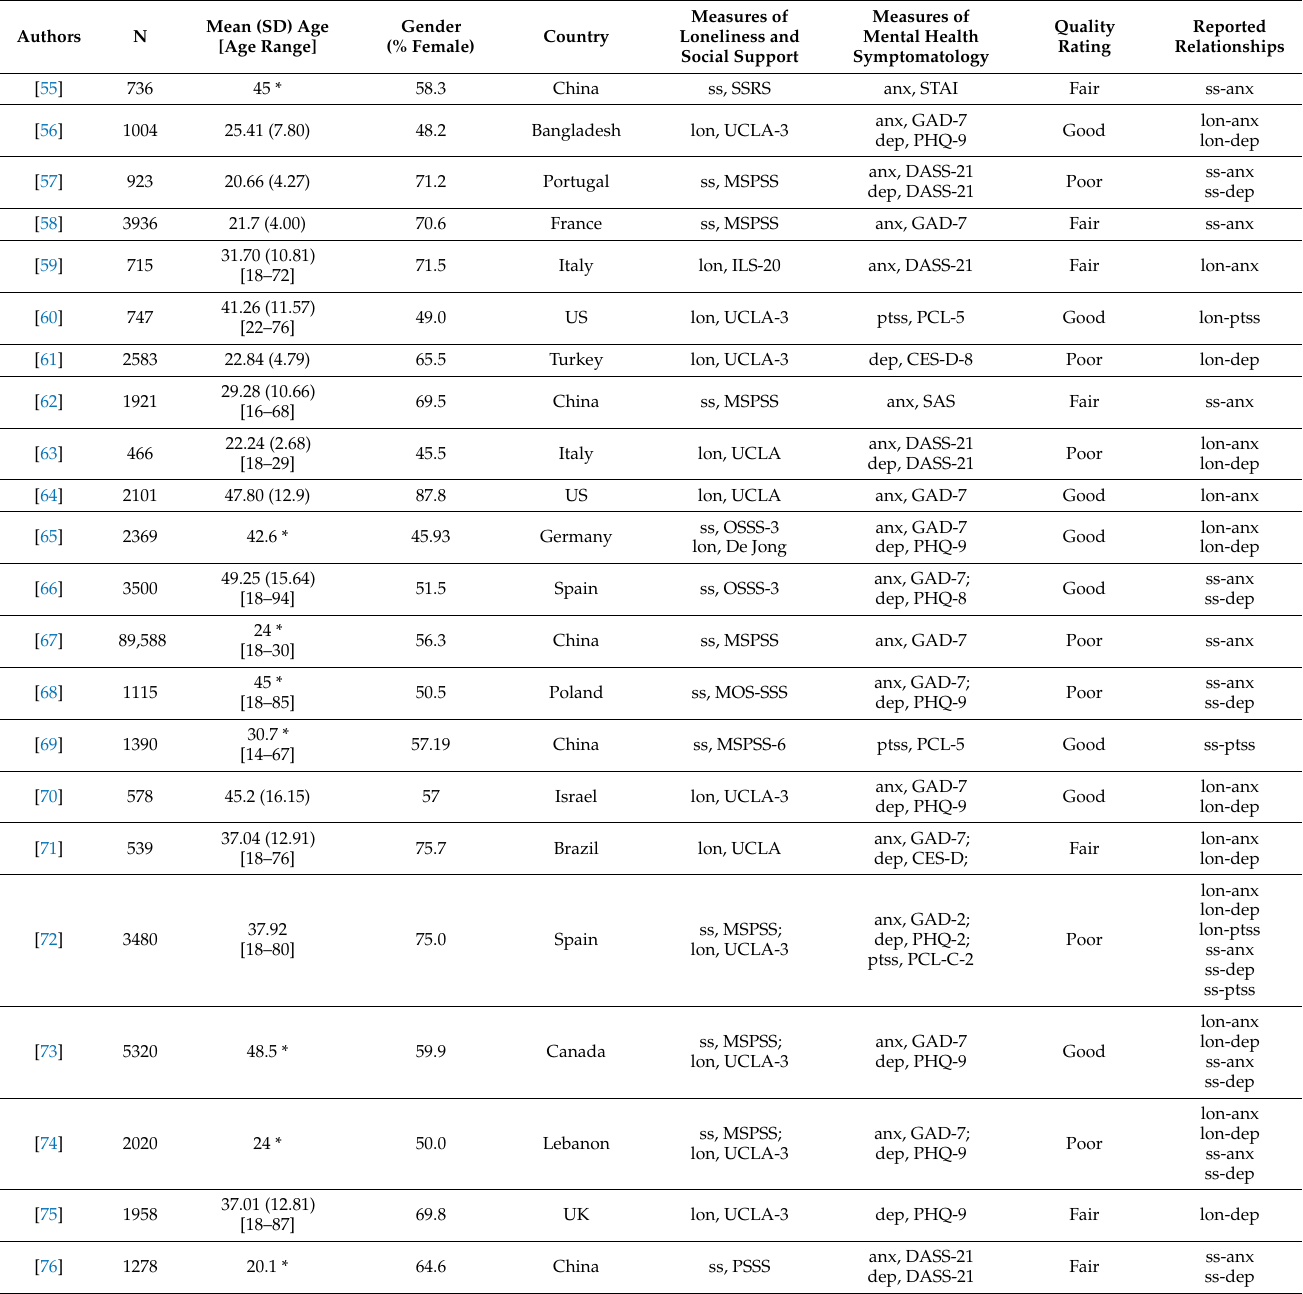
Table 1. Overview of included